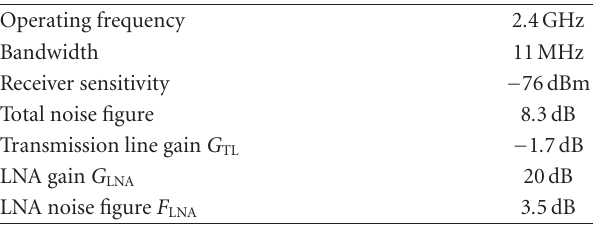
Table 3: A typical receiver for WLAN 802.11 b standard [17].